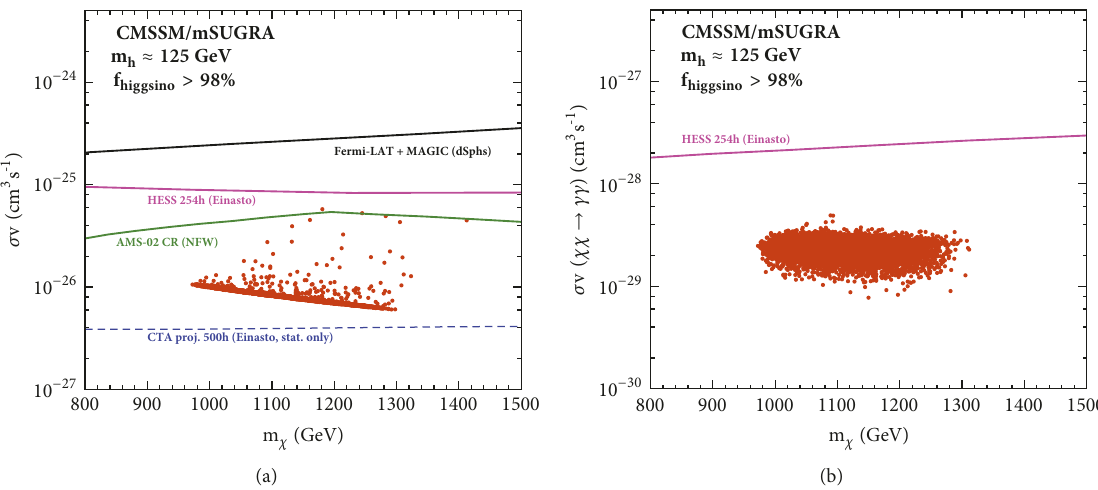
Figure 6: (a) Indirect detection bounds and projections in gamma-ray searches in space and terrestrial telescopes for ∼ 1 TeV higgsino DM under CMSSM/mSUGRA boundary conditions. Solid black line shows 90% CL upper bounds on the present-day annihilation cross section to 𝑊 + 𝑊 − from the statistical combination of Fermi-LAT and MAGIC observations of dSphs [88]; solid magenta line shows the recent bound from 10-year observation of the Galactic Center at HESS [89] under the Einasto profile assumption; solid green line shows the upper bound from antiproton cosmic-ray (CR) data at AMS-02 [90] according to [91] for the NFW profile; and dashed blue line shows the projected reach of CTA 500h under the Einasto profile assumption [53]. (b) In magenta, the current 95% CL upper bound on the annihilation cross section (times velocity) to gamma-ray lines, 𝜎 훾훾 V , from HESS [92] under the Einasto profile assumption, compared to the cross section of our ∼ 1 TeV higgsino points.